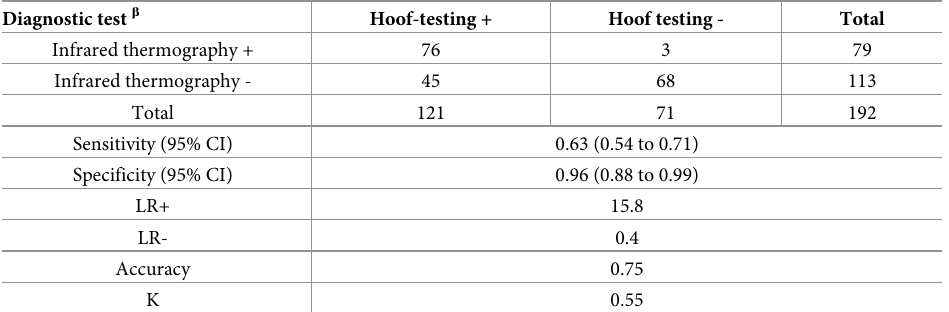
Table 4. Comparison of the infrared thermography with the gold standard hoof testing for the diagnosis of oligo- fructose-induced laminitis in cattle.